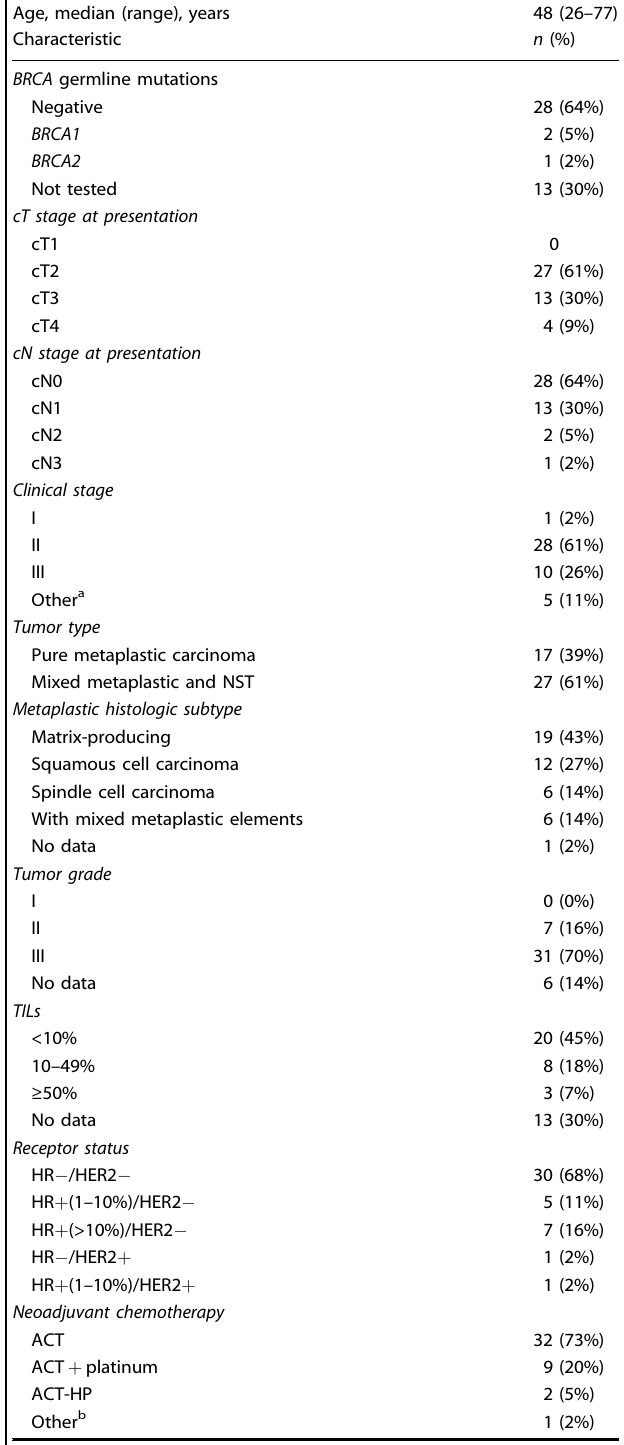
Table 1. Clinicopathological characteristics